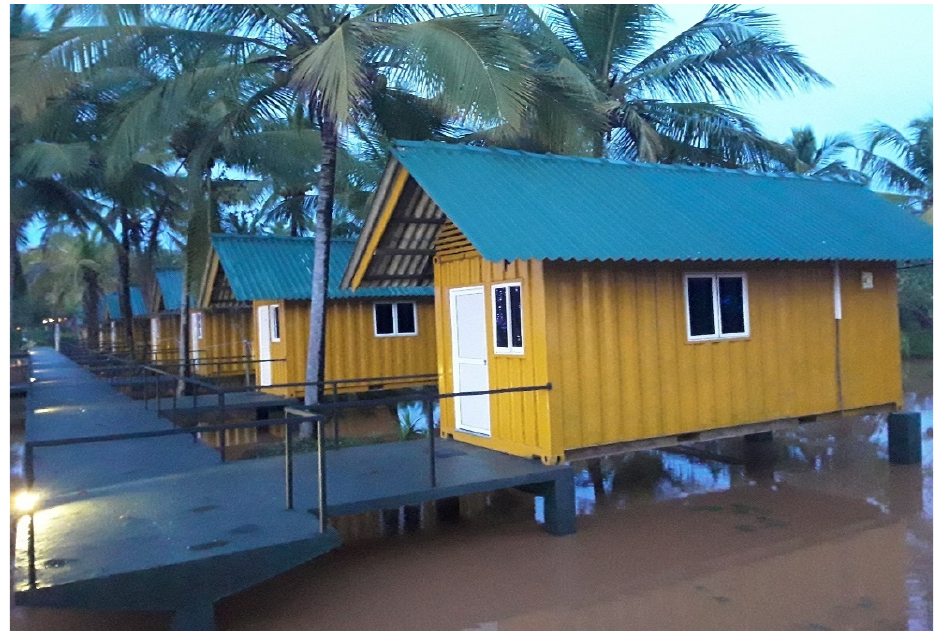
Figure 7. Newly built kuti -s ( small huts or lodgings), Photo by author. 19 October 2019, Umandawa Monastery, Kurunegala.